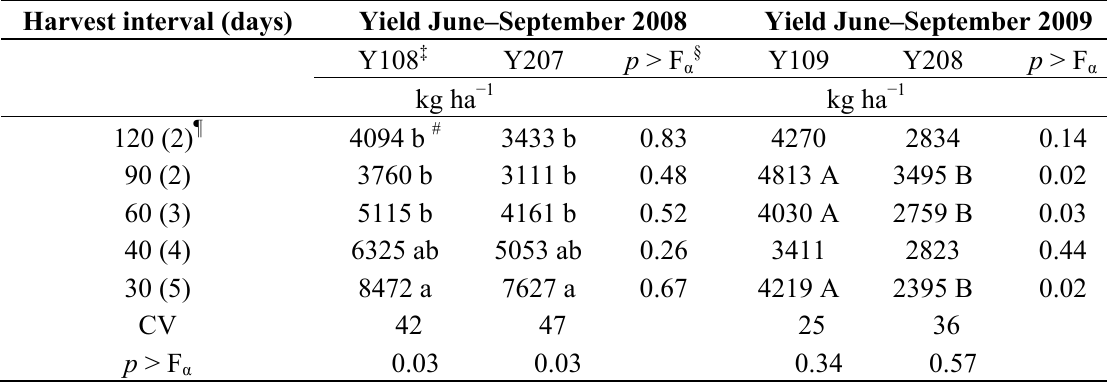
Table 4. Effects of harvest interval on cumulative June-September forage per area, after May harvest, of first and second year plots of mixed native grass stands † harvested in two consecutive